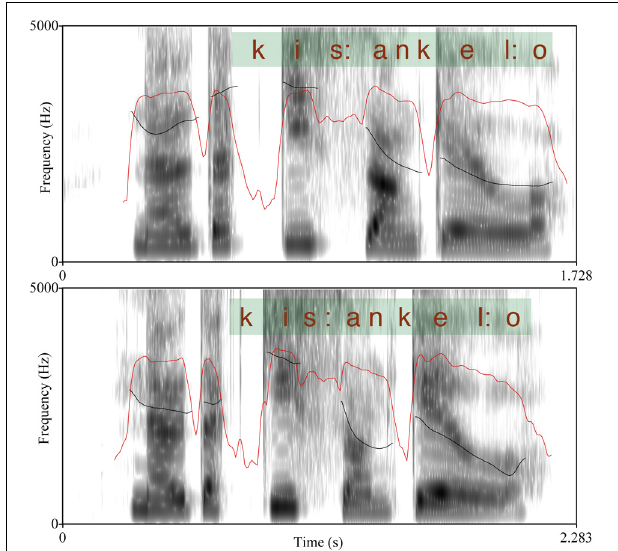
FIGURE 1 | Example of the spectrum of a compound word (above; audio file 1) and a two-word phrase (audio file 2) with f0 (black line) and intensity (red line) contours. The scale is 9–400Hz for f0 and 0–100dB for intensity.